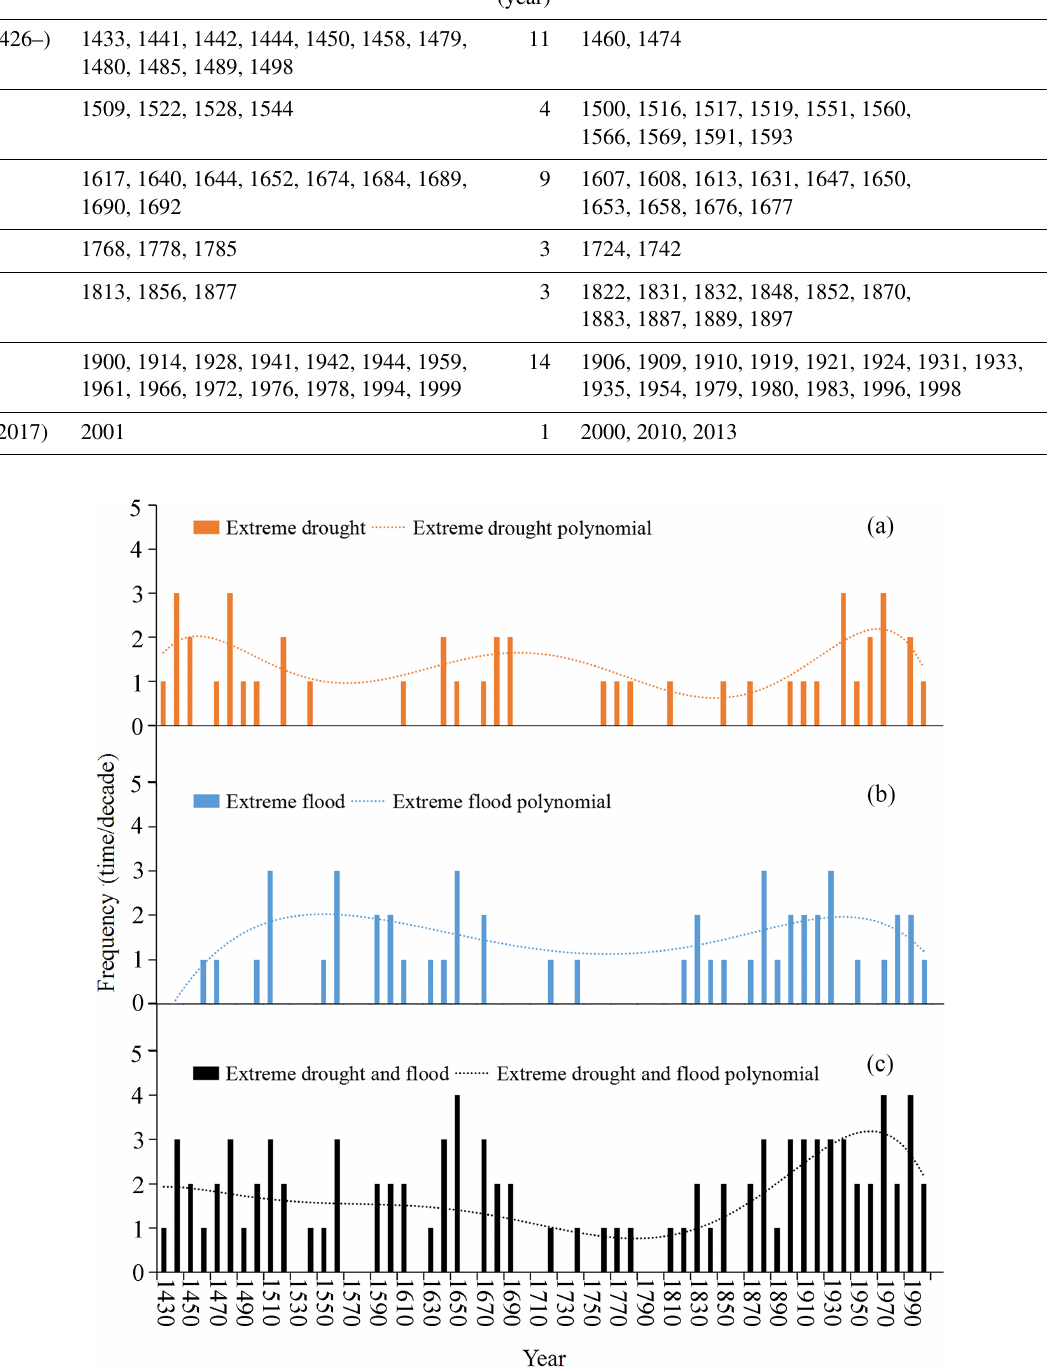
Figure 4. Change in the frequency of extreme droughts and floods during 1430–2009 (times per decade). (a) Years of extreme droughts; (b) years of extreme floods; (c) years of extreme droughts and floods. The dotted line is the sixth-order polynomial fit curve.